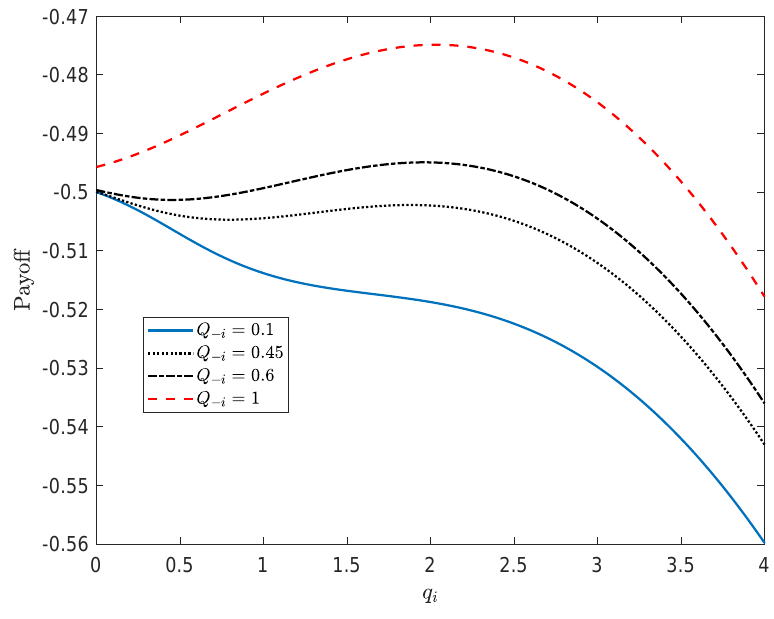
Figure 4. h i ( ϕ ∗ , q i , q − i ) with Different Q − i